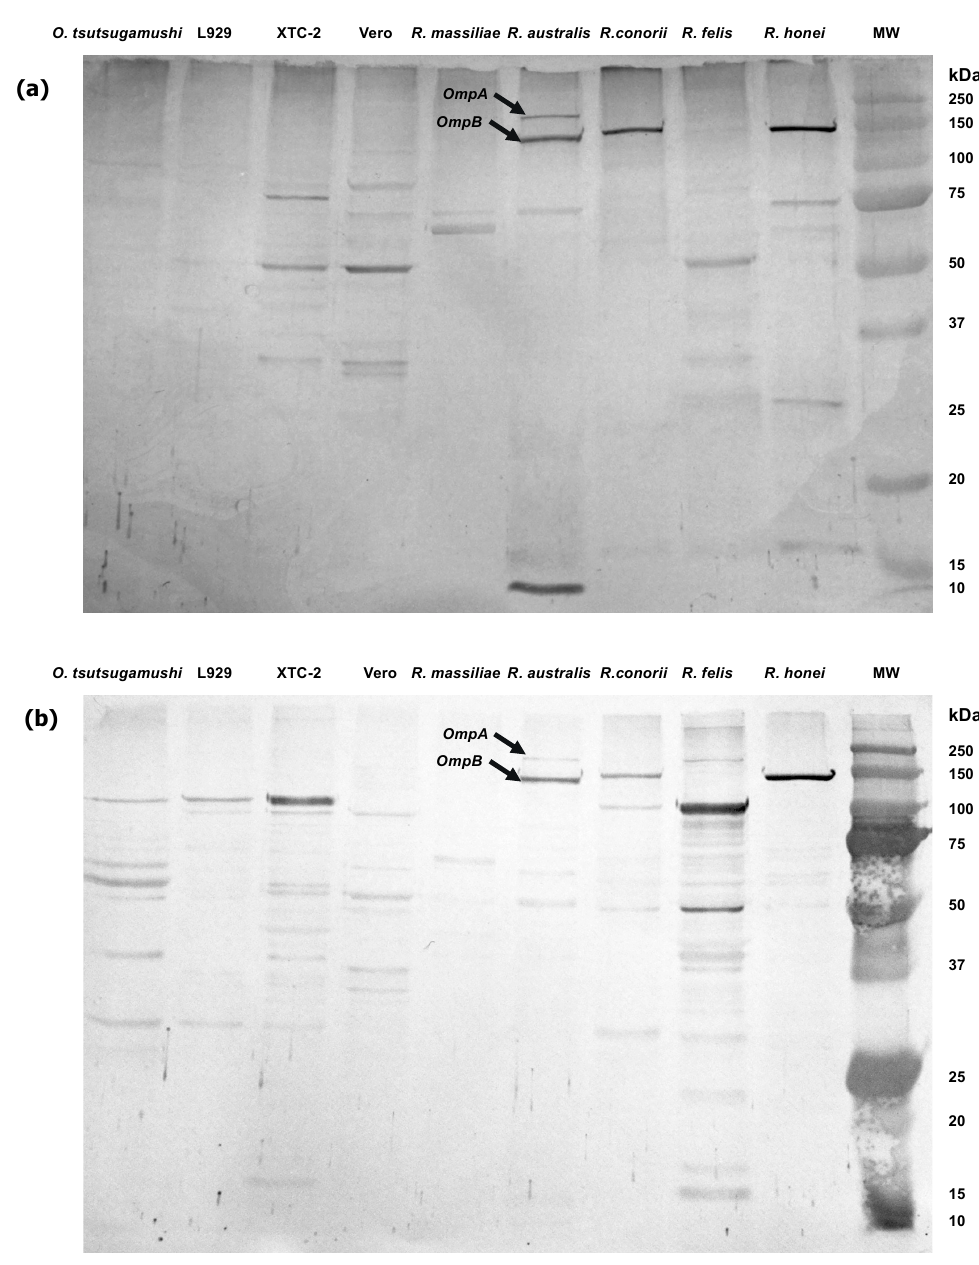
Figure 2. Western blot of the patient’s serum reacted at a 1:80 dilution against host cell cultures and Orientia and Rickettsia spp. antigens using ( a ) IgM and ( b ) IgG conjugates. L929, Vero and XTC-2 are continuous cell lines used to propagate R. massiliae (Vero), R. conorii (L929), R. felis (XTC-2), R. honei (L929), R. australis (Vero) and Orientia tsutsugamushi (L929). MW = molecular weight marker in kiloDaltons (kDa).